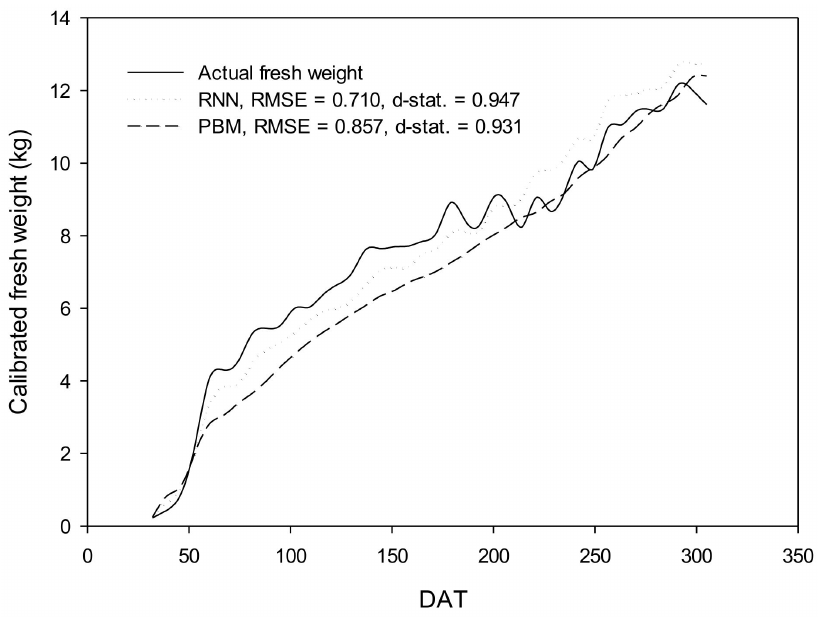
Figure 10. Comparison of the calibrated fresh weights estimated by the recurrent neural network (RNN) algorithm and the process-based model (PBM) with days after transplanting (DAT) in growth validation